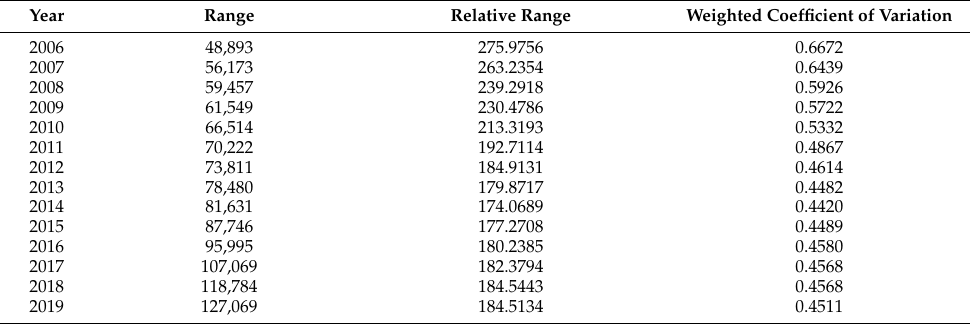
Table 2. Uneven regional development measured by China’s per capita